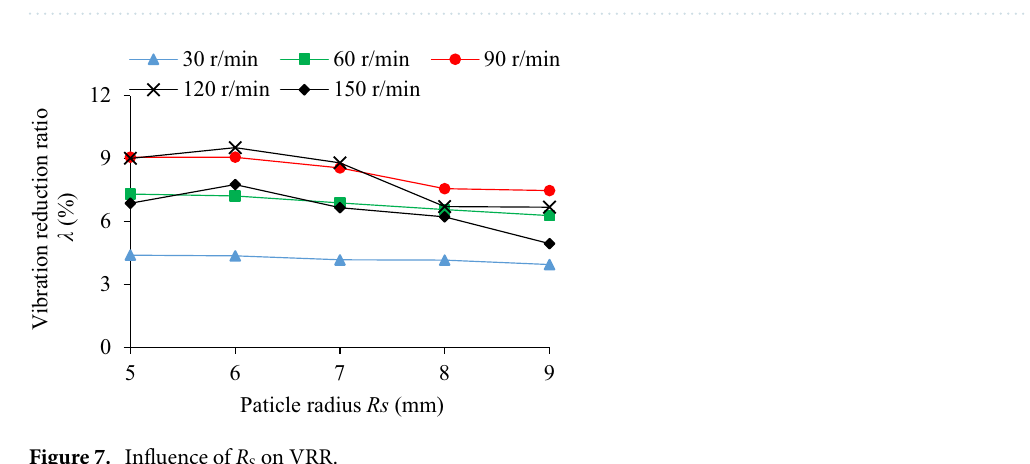
Figure 6. Influence of R S on TEC.